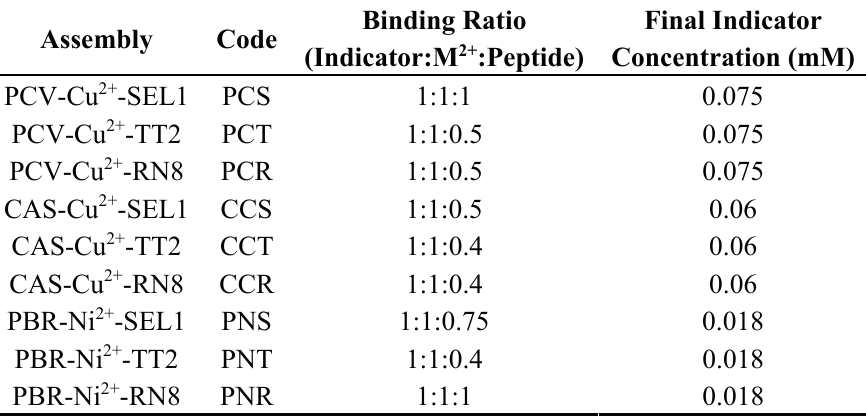
Table 4. Composition of individual receptors used in this